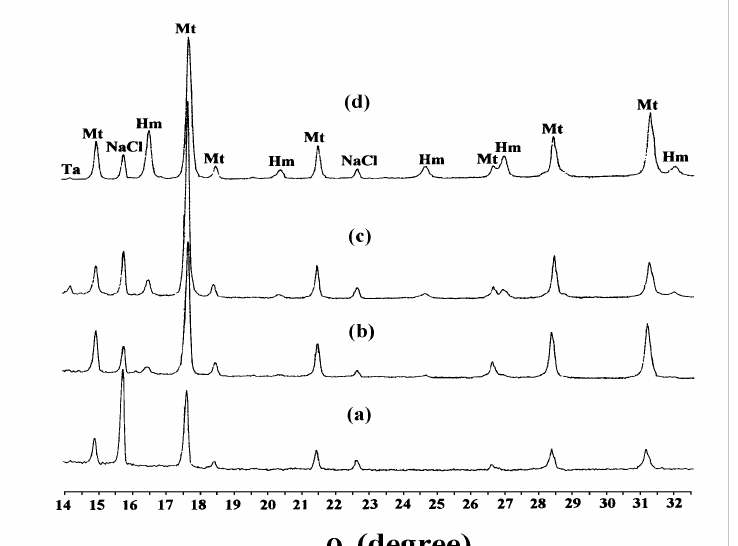
Figure 1. Powder X-ray patterns of (a) fresh rock; (b) altered rock; (c) soil-sand and (d) soil-silt. Radiation CuK aa aa a . Hm = hematite, Mt = magnetite, Ta = talc. NaCl = internal